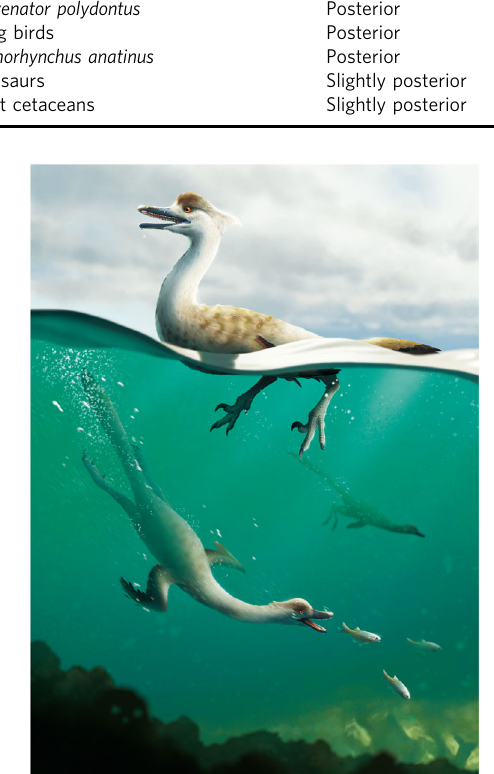
Fig. 5 Life reconstruction of Natovenator polydontus (Artwork by Yusik Choi). The reconstruction shows the proposed swimming behaviour of Natovenator polydontus